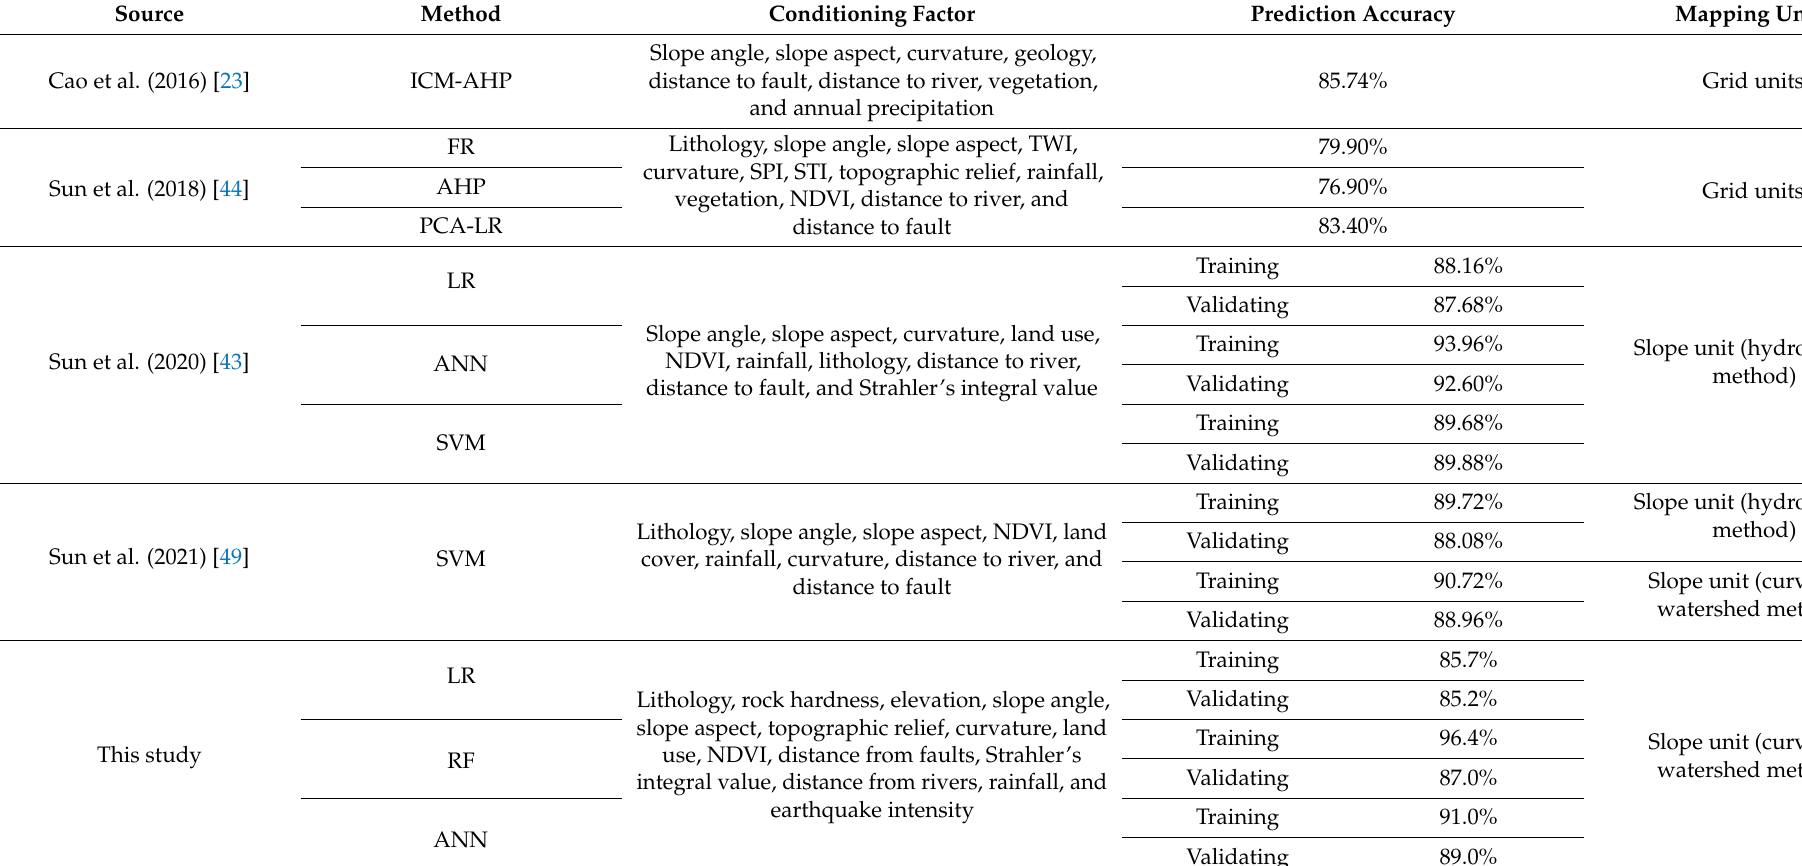
Table 5. Prediction accuracy of the landslide susceptibility models from different studies